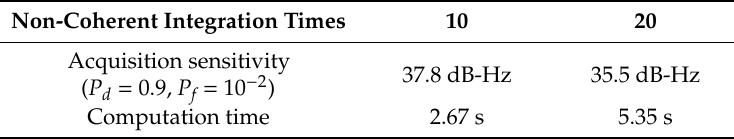
Table 4. The acquisition sensitivity and computation time of NCH methods.